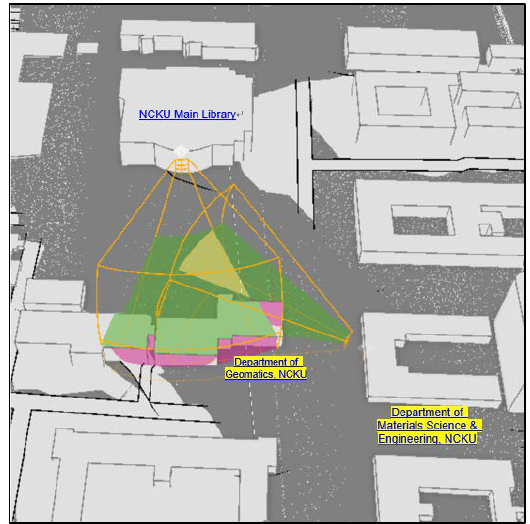
Figure 4. 3D FOV CCTV monitor field of view for area B Figure 4 shows the analyzed outcome for the CCTV in Area B. Similar phenomena is found after 3D perspective is considered.